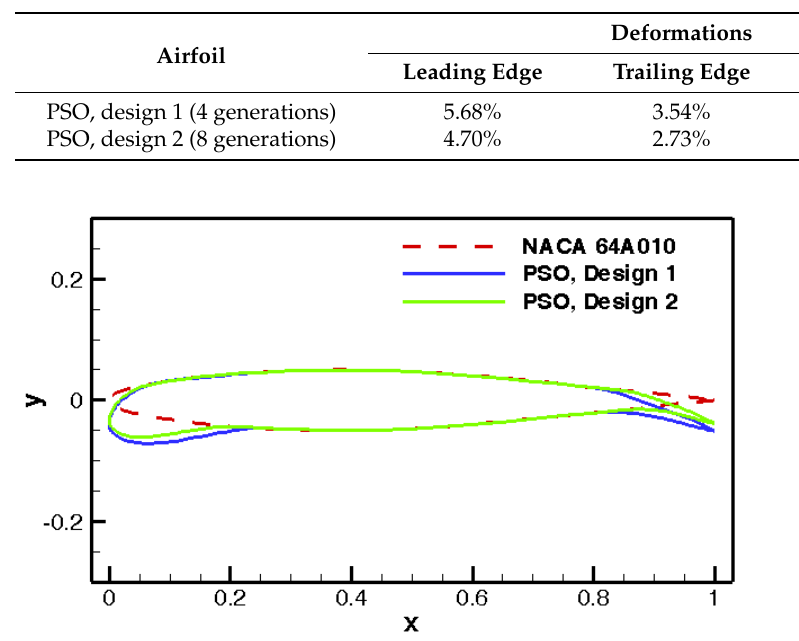
Figure 6. Final solutions of PSO algorithm using the aggressive (design 1, four generations) and the conservative (design 2, eight generations) setup.